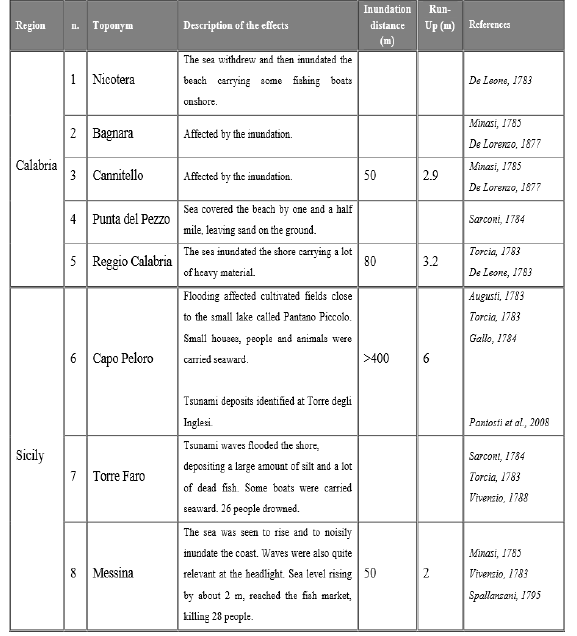
Figure 5. Summary of evidence of the 1783 tsunami in Calabria and Sicily, with the exclusion of local effects in the area of Scilla.